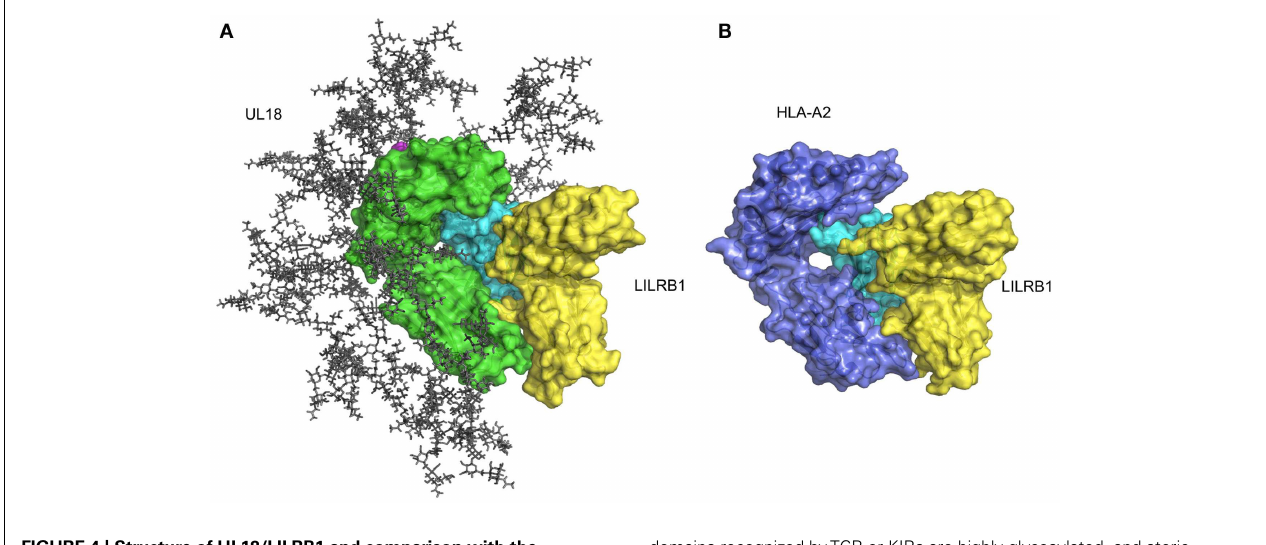
FIGURE 4 | Structure of UL18/LILRB1 and comparison with the HLA-A2/LILRB1 complex. (A) The crystal structure of the UL18/LILRB1 complex (UL18 in green, β 2m in cyan, peptide in magenta, LILRB1 in yellow; PDB ID: 3D2U) with complex carbohydrate models attached to the 13 potential N -glycosylation sites.The α 1– α 2